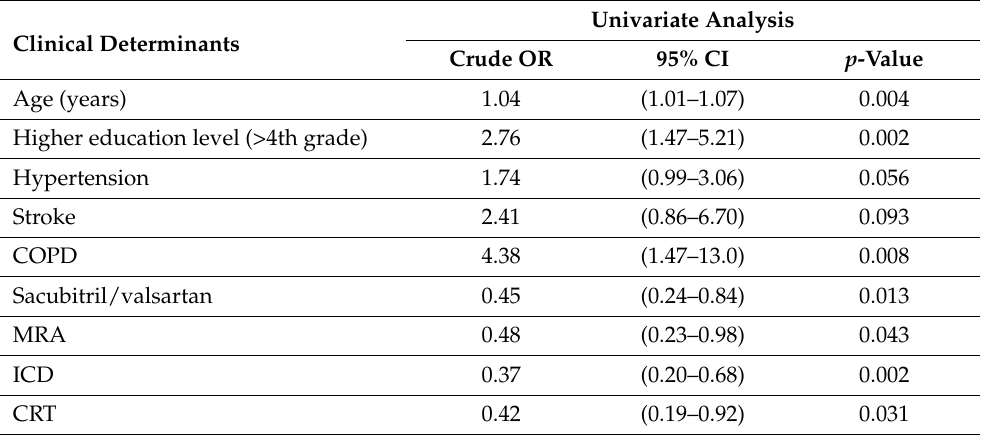
Table 4. Clinical determinants of non-enrollment in a CR program of patients with heart failure with reduced ejection fraction—univariate analysis and respective crude odds ratio